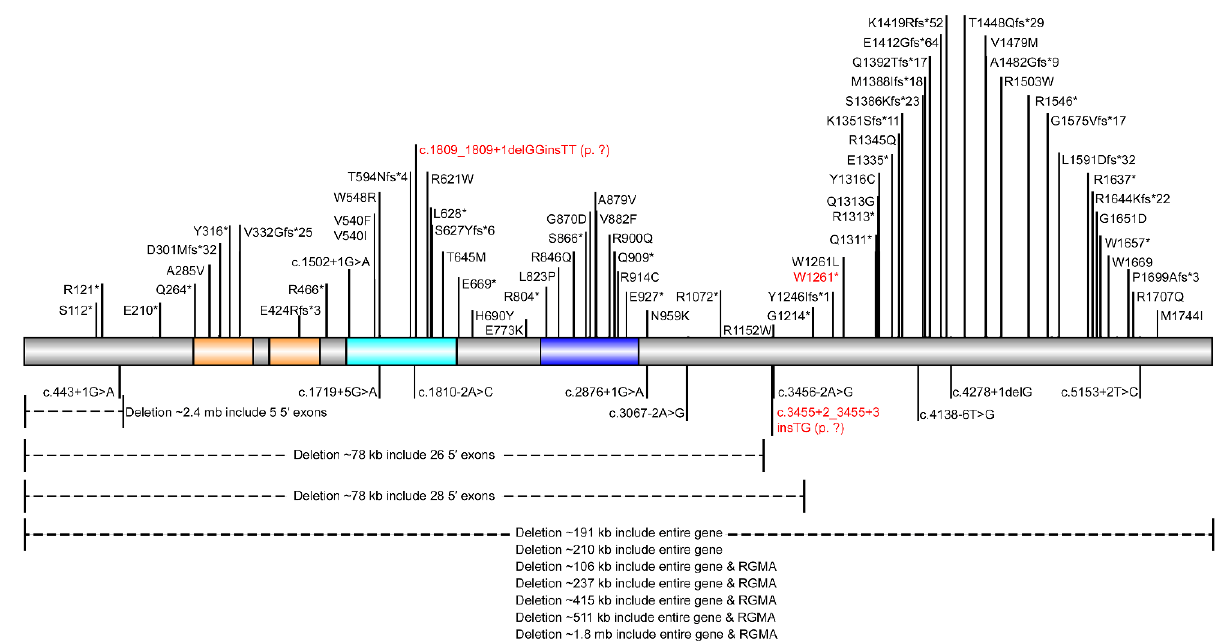
Figure 3. Schema of CHD2 with disease-causing mutations reported in patients. CHROMO domains, helicase ATP-binding domain, and helicase C-terminal domain were colored in orange, cyan, and blue, respectively. Novel pathogenic/likely pathogenic variants reported in this study were presented in red